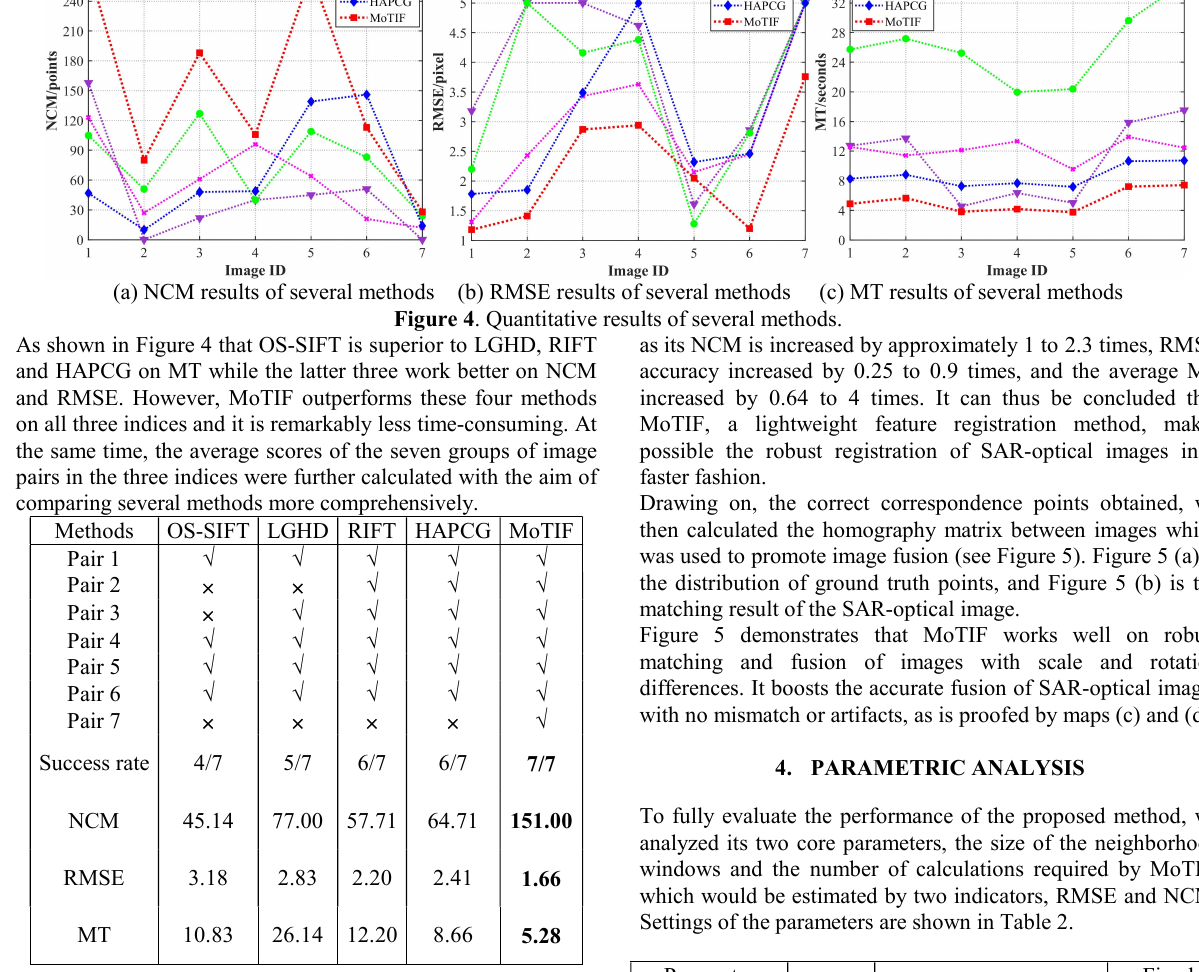
Table 1 . Average quantitation matching scores of seven groups SAR-optical images of our MoTIF and four competitors.